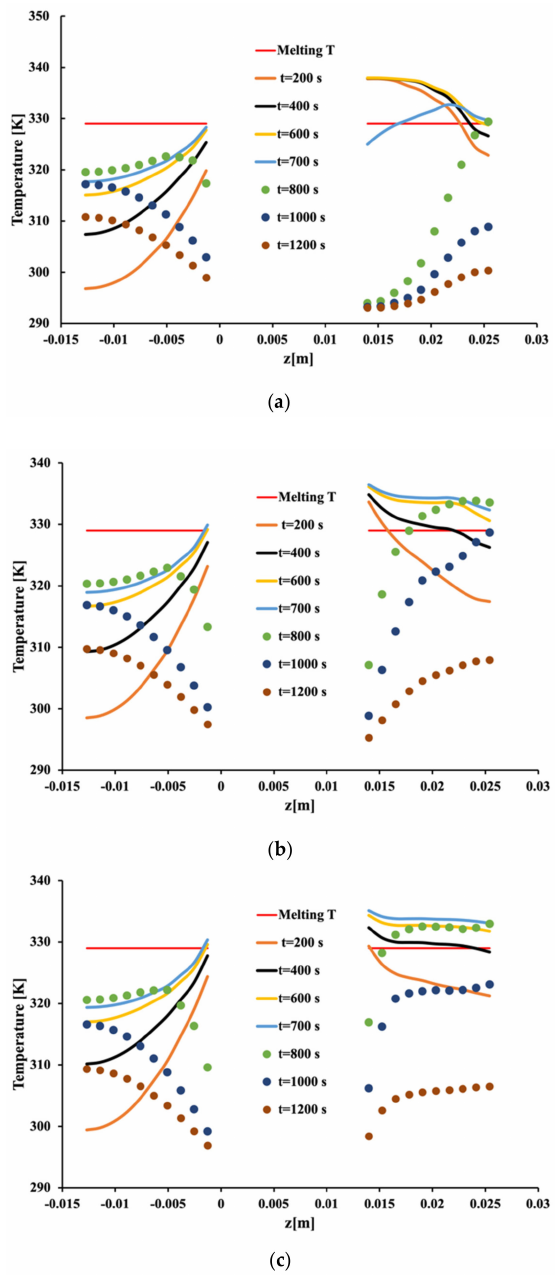
Figure 8. Temperature distribution along the z-axis in the middle of the phase change material. (With pin-fins, ( a ) Re = 50, ( b ) Re = 100, ( c ) Re =